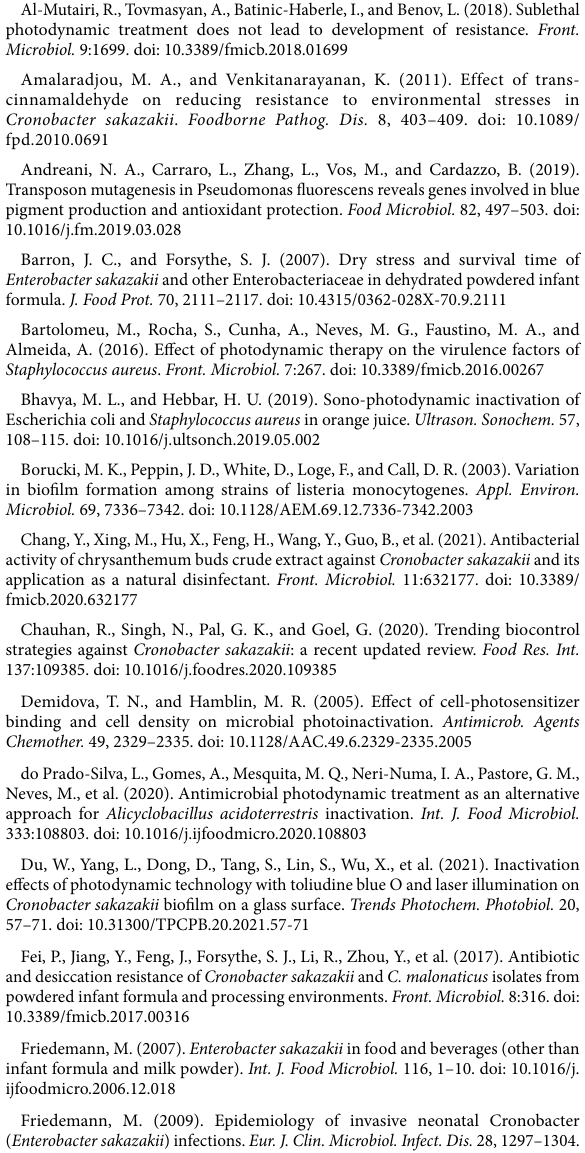
SUPPLEMENTARY FIGURE S2 The inhibitory effect of saline and DMSO on C. sakazakii . No photosensitizer was supplemented in this test, and L refers to the illumination with 460 nm-LED. Values are the mean ± SEM (standard error of mean) from 3 replicates. ns, p > 0.05. SUPPLEMENTARY FIGURE S3 ROS stimulated by aPDI on Δ CpxA mutant strain. After DCFH-DA staining, representative microscopy images (A) and fluorescence density (B) were shown. Scale bar represents 50 μm. Values are the mean ± SEM (standard error of mean) from 3~4 replicates. * p < 634 0.05, ** p < 0.01, *** p <